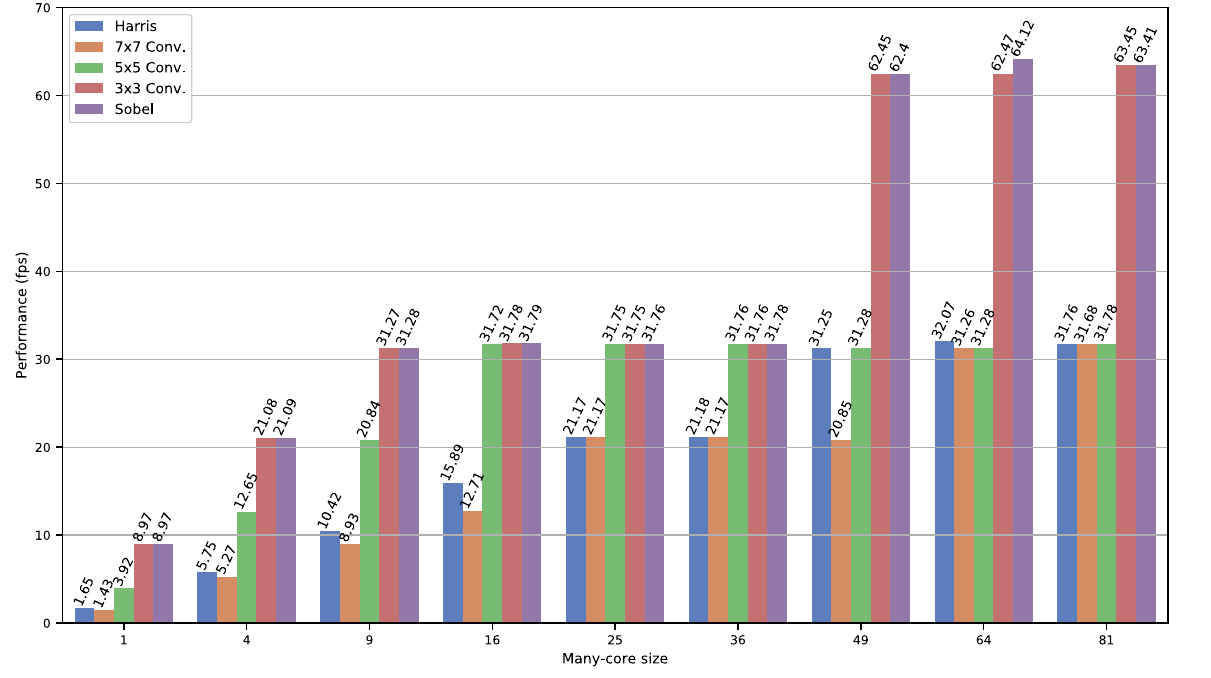
Figure 11. Execution time for multiple algorithms with acquisition and visualization